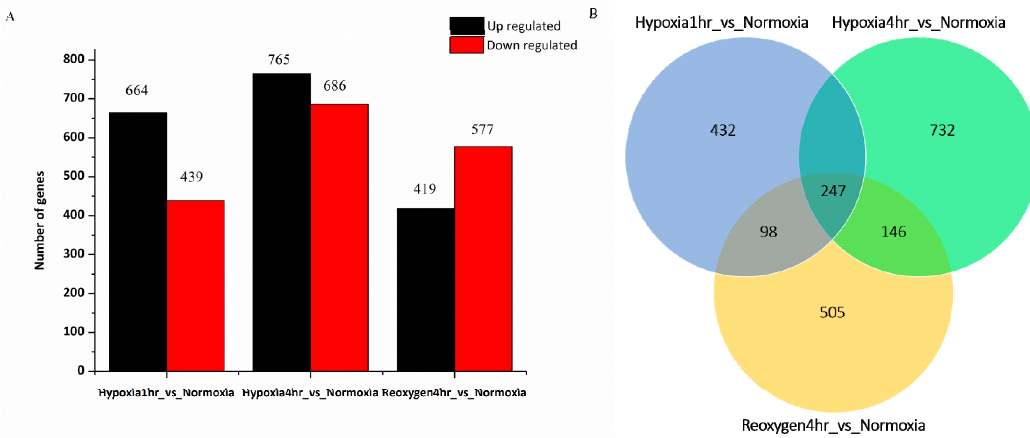
Figure 1. Di ff erent expression profiles. Notes: ( A ) The number of up- and down-regulated di ff erentially expressed genes (DEGs) in each comparison group; ( B ) Venn diagram of all DEGs under hypoxia1h, hypoxia4h and reoxygen4h compared to normoxia group. Genes expressed only in hypoxia1h group (yellow circle); genes expressed only in hypoxia4h group (light blue circle); genes expressed only in reoxygen4h group (light purple circle). (log 2 foldchang > 1.0 and padj < 0.05). Table 2. Annotation of the top ten differential expression genes in three treatment groups (padj < 0.05). Gene